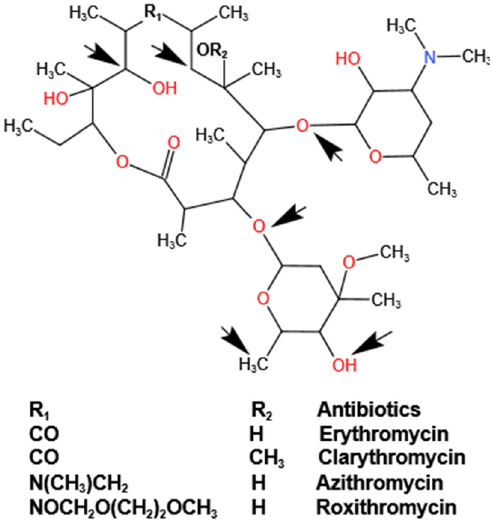
Figure 5. The possible attack site of ·OH against several macrolides. Reproduced with permission from Babic et al., Curr. Opin. Green Sust . [121]; published by Elsevier, 2017. Many AOPs are based on a combination of strong oxidants (e.g., ozone, hydrogen (e.g., ultraviolet or ultrasound). Suwannaruang et al. [123] used